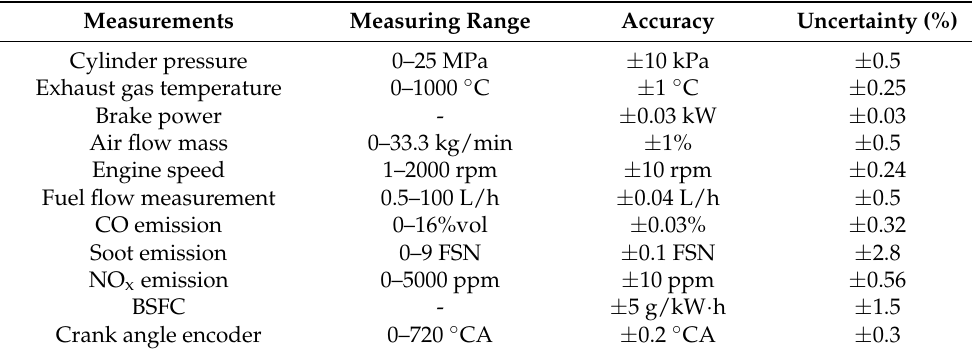
Table 4. List of measurements, measuring accuracy, and measuring range. Measurements Measuring